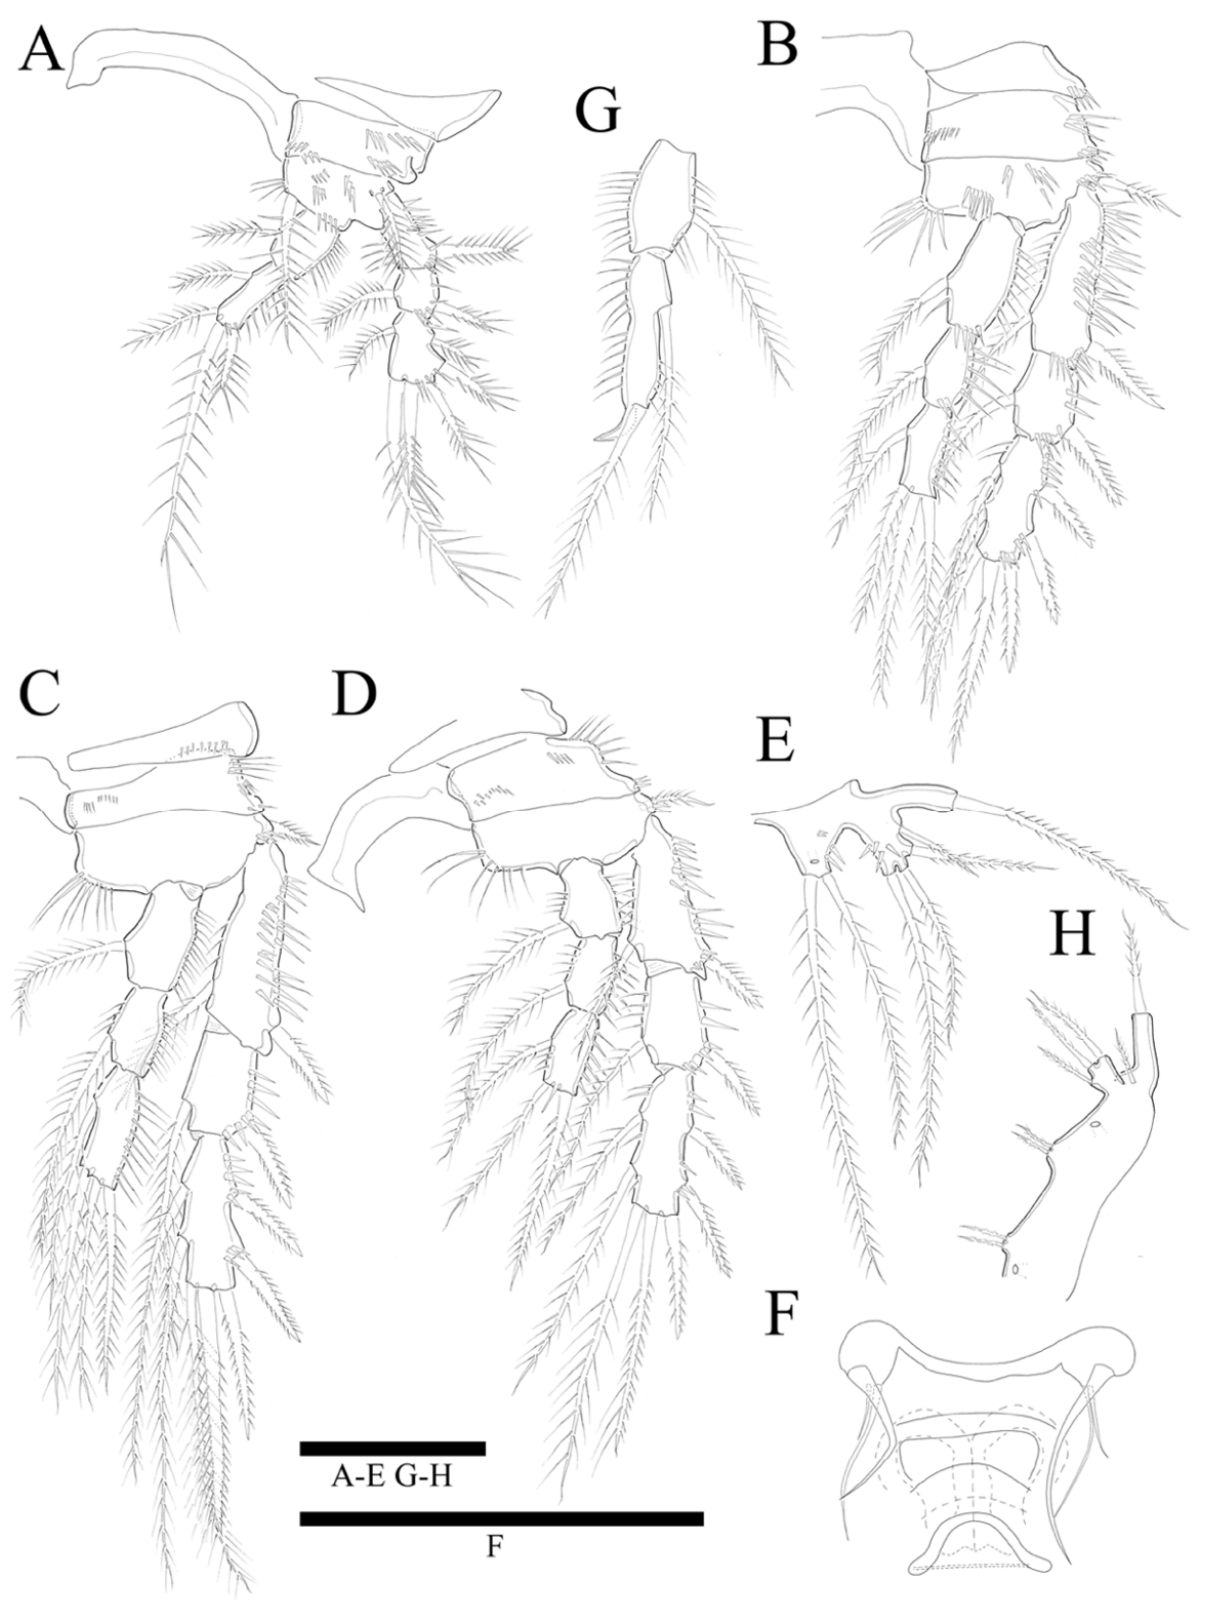
Figure 5. Zosime montagnai sp. nov. Female. ( A ) P1; ( B ) P2; ( C ) P3; ( D ) P4; ( E ) P5; ( F ) P6. Male. ( G ) P2 endopod; ( H ) P5. Scale bars: 50 µm.